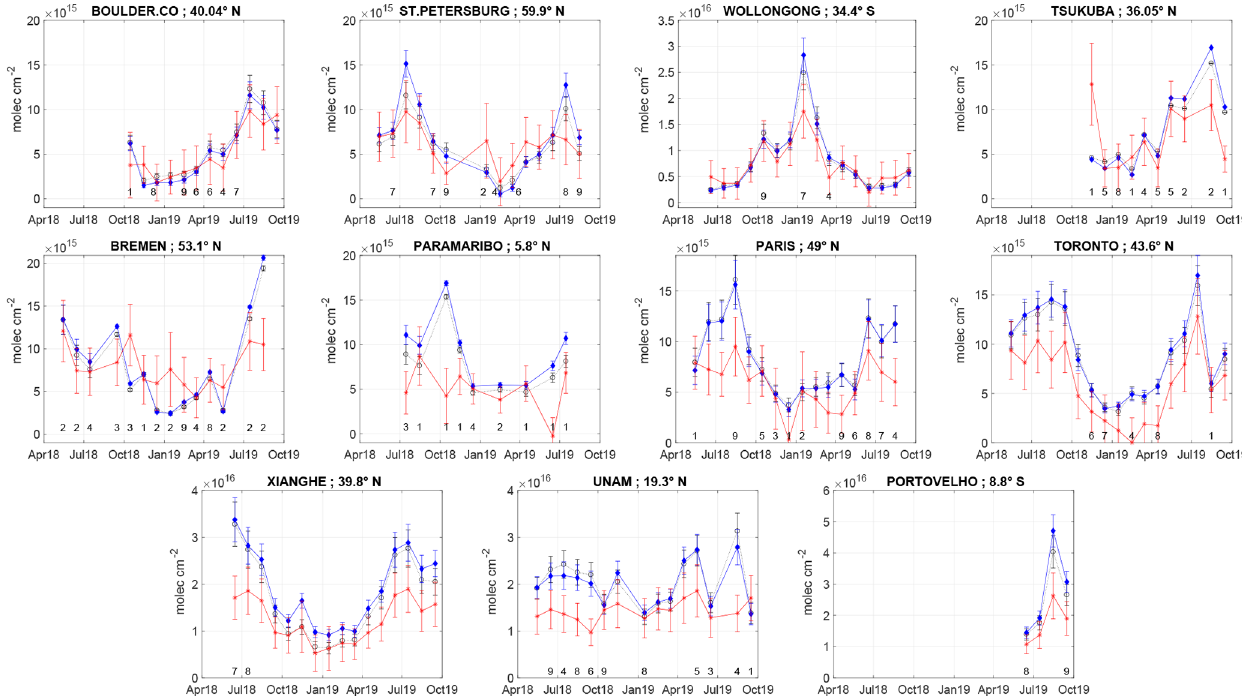
Figure 5. Monthly mean time series of FTIR raw data (black), FTIR data smoothed with the TROPOMI column averaging kernel (blue), and TROPOMI (red) at each site. Only data in coincidence are included in the monthly mean to avoid sampling bias. When the number of coincidences within 1 month is smaller than 10, it is written below the monthly